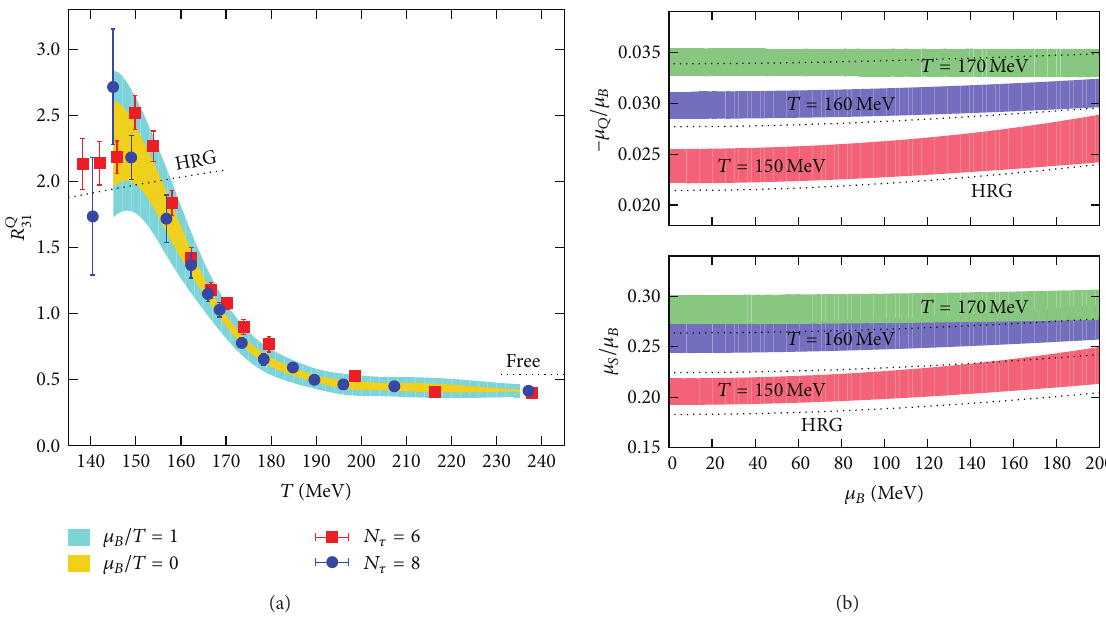
Figure 15: In (a), the leading term for 𝑅 𝑄 31 shown in the yellow band is compared to its NLO term denoted by the blue band in the continuum limit. In (b), the ratios of 𝜇 𝑄 and 𝜇 𝑆 with respect to 𝜇 𝐵 are compared with the HRG model predictions at different temperatures. Both figures are from [109].